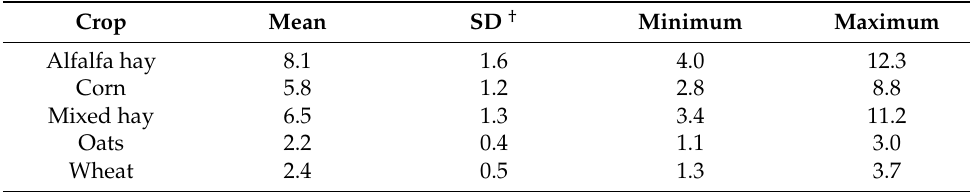
Table 2. Mean and distribution of expected crop yields (MT · ha − 1 ) under good management across soil components as published in yield tables from West Virginia soil surveys conducted between 1959 and 1997 ( n =